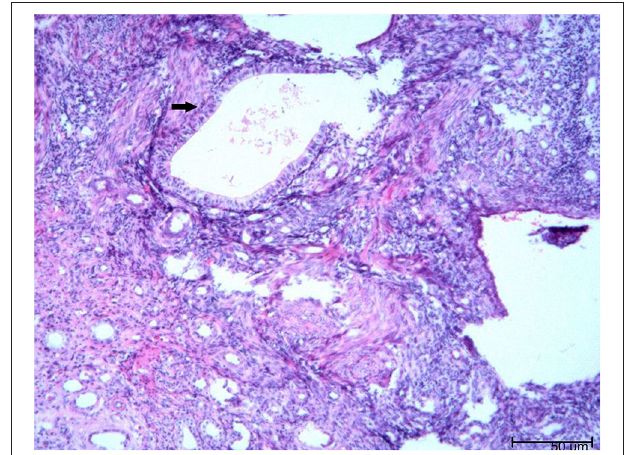
FIGURE 2 | The microscopic pathology proved the diagnosis of renal endometriosis characterized by endometrial glands and embedded stromal cells [hematoxylin and eosin stain (H and E), × 200